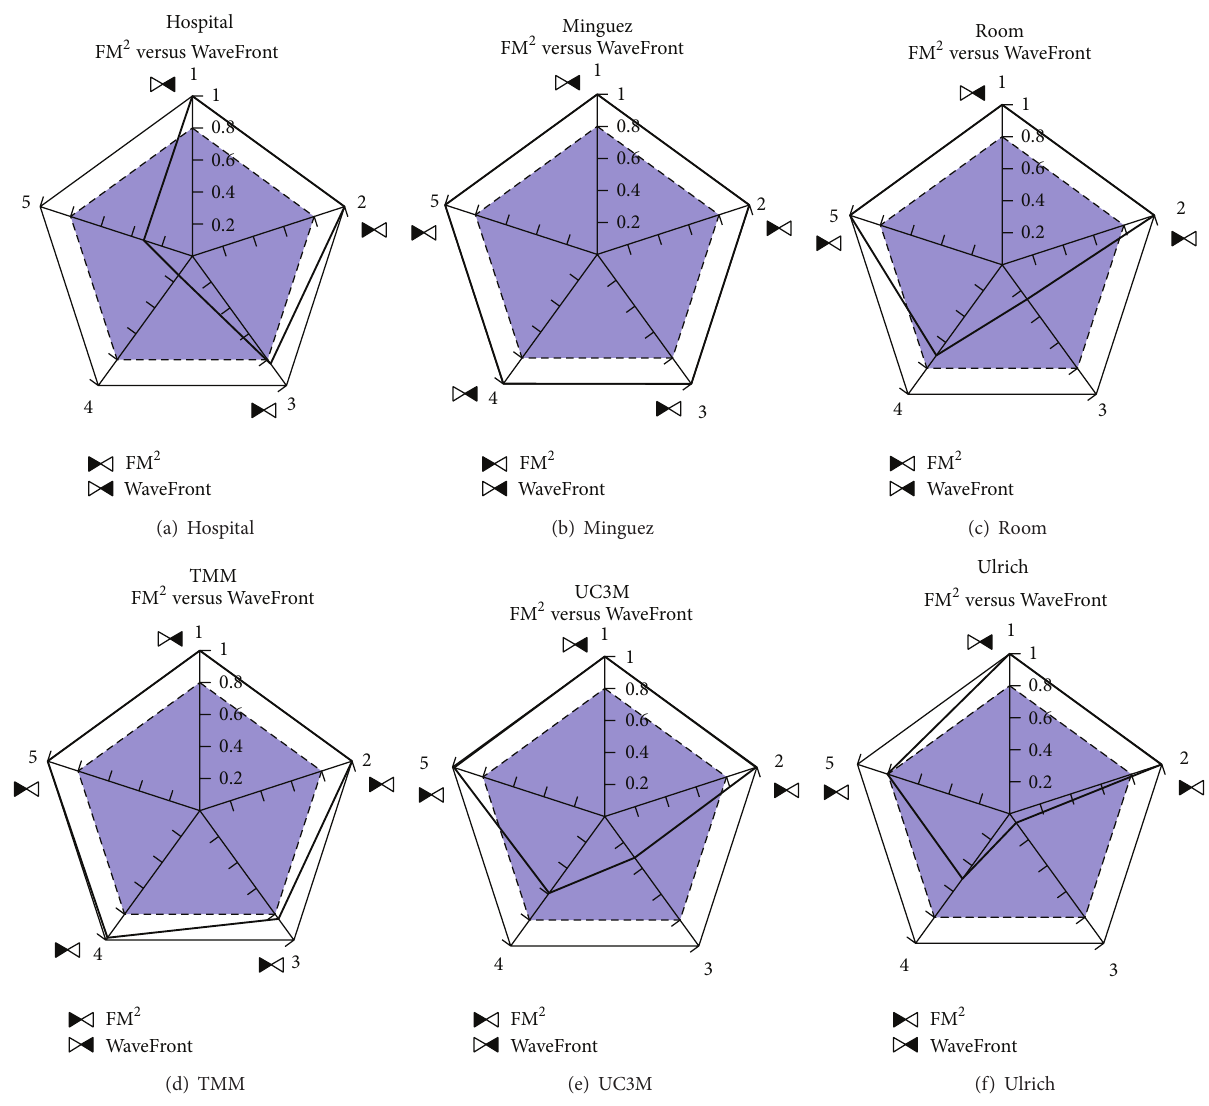
Figure 8: Results for each